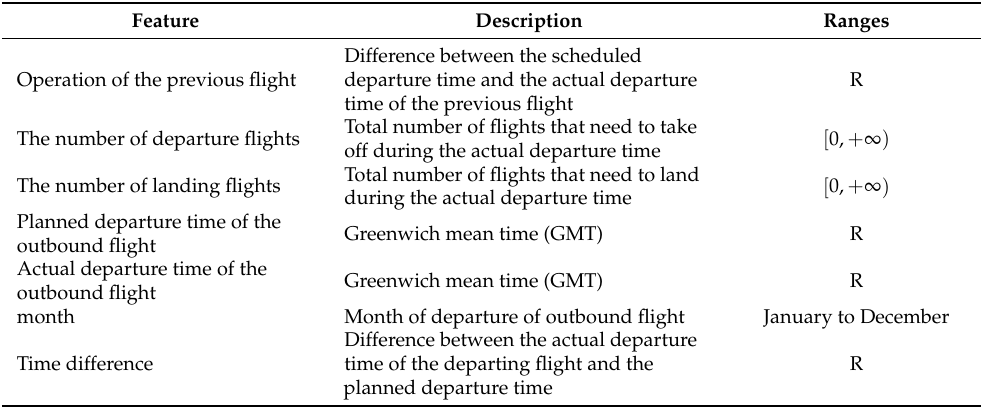
Table 2. Feature description and value